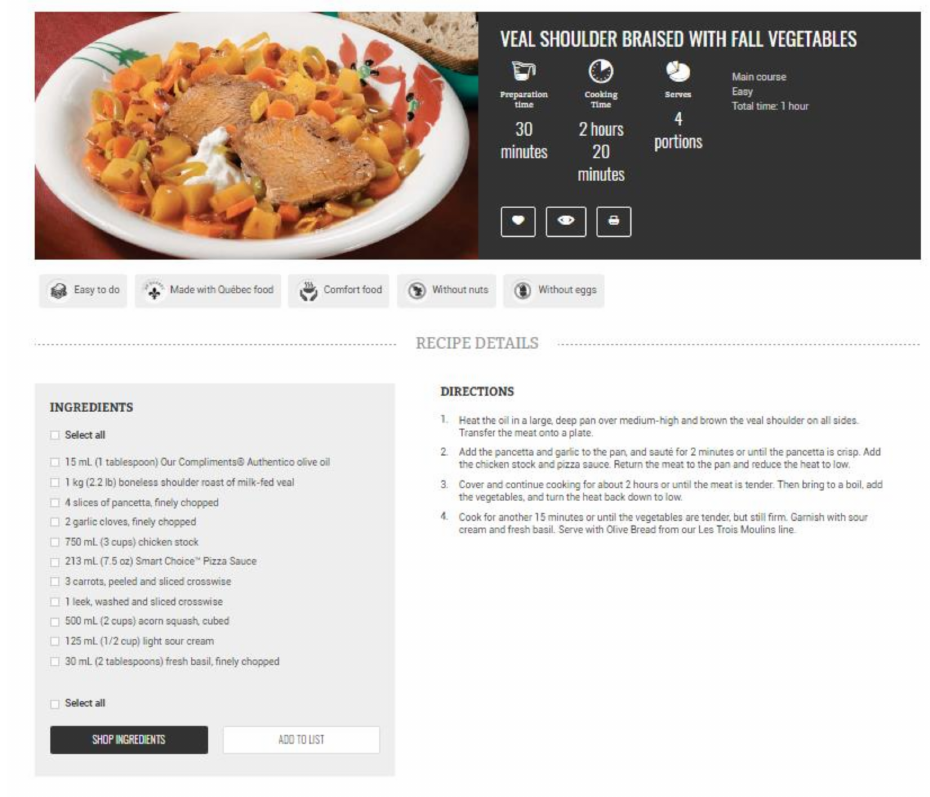
Figure A2. Recipe used for the condition with Low arithmetic complexity and experience